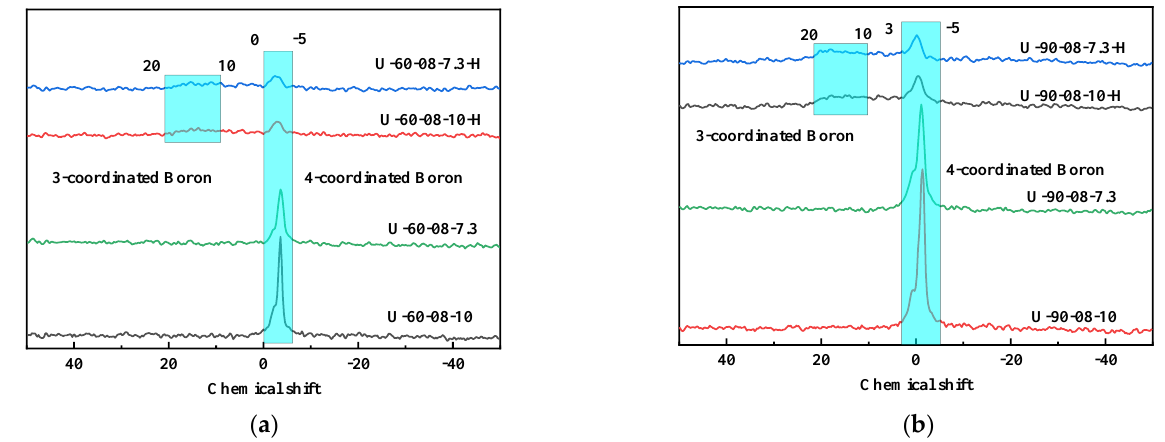
Figure 12. 11 B MAS NMR of ( a ) as made and ( b ) calcined samples. 29 Si MAS NMR spectra were used to investigate the silicon coordination. As dis- played in Figure 13, the chemical shifts of −110/−98/−89 are assigned to the characteristic peak positions of Q 4 /Q 3 /Q 2 , respectively, and the chemical shifts of −103/−93 may be as- signed to Si(1T)/Si(2T) connected 29 Si atoms (T is boron or aluminum atom) [20]. Com- pared with the EWT-H zeolite, the position of the characteristic peak of Q 4 of the samples U-60-08-10/U-60-08-7.3/U-90-08-10/U-90-08-7.3 remains unchanged, and the chemical shift of -103/-93 could be ascribed to different inequivalent T-sites of the zeolite frame- works, which may generate more acid centers (Figure 13a). This is consistent with the acidic results (Table 3).